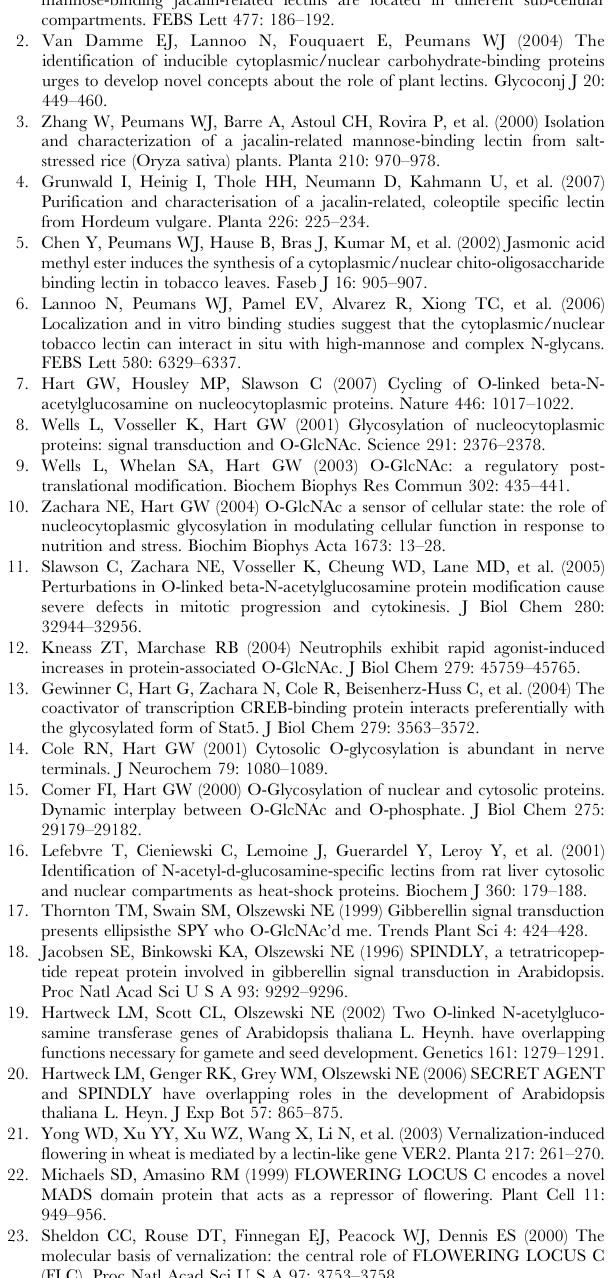
heading stage in winter wheat. (A) Heading stages for analysis. S1, before heading stage; S2, during heading stage. Corresponding panicles were shown below. (B) Expression patterns and abundance of VER2 during different development stages of panicle. Expression level of tubulin detected by immunoblotting was used as loading control. Found at: doi:10.1371/journal.pone.0004854.s002 (2.82 MB